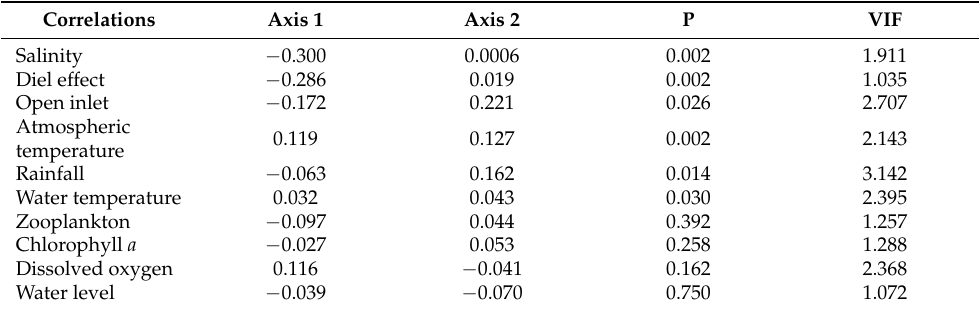
Table 2. Correlations between environmental variables and species-derived sample scores, signifi- cance and variance inflation factors (VIF) from redundancy analysis (RDA).